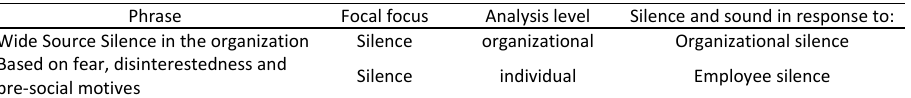
Table 3: The Third wave of evolution of organizational silence (Edwards et al ., 2009) Table 3. The Third wave of evolution of organizational silence (Edwards et al ., 2009